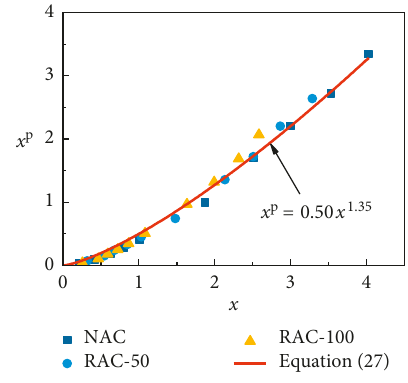
Figure 13: Comparison between the plastic strain and the total strain of the RAC obtained using equation (27) and from reference